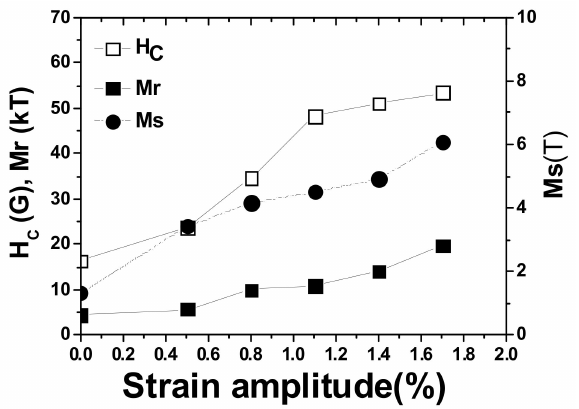
Figure 6. Change in the magnetic coercivity (Hc), saturation magnetization (Ms), and remanence (Mr) of the fatigue-failed specimens under various strain